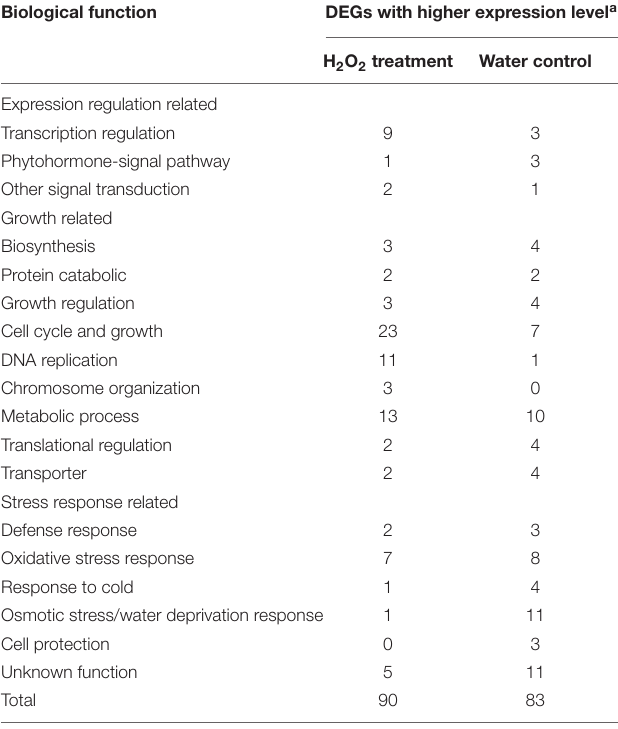
a DEGs, differentially expressed genes. The complete list of DEGs between H 2 O 2 treatment and water control and